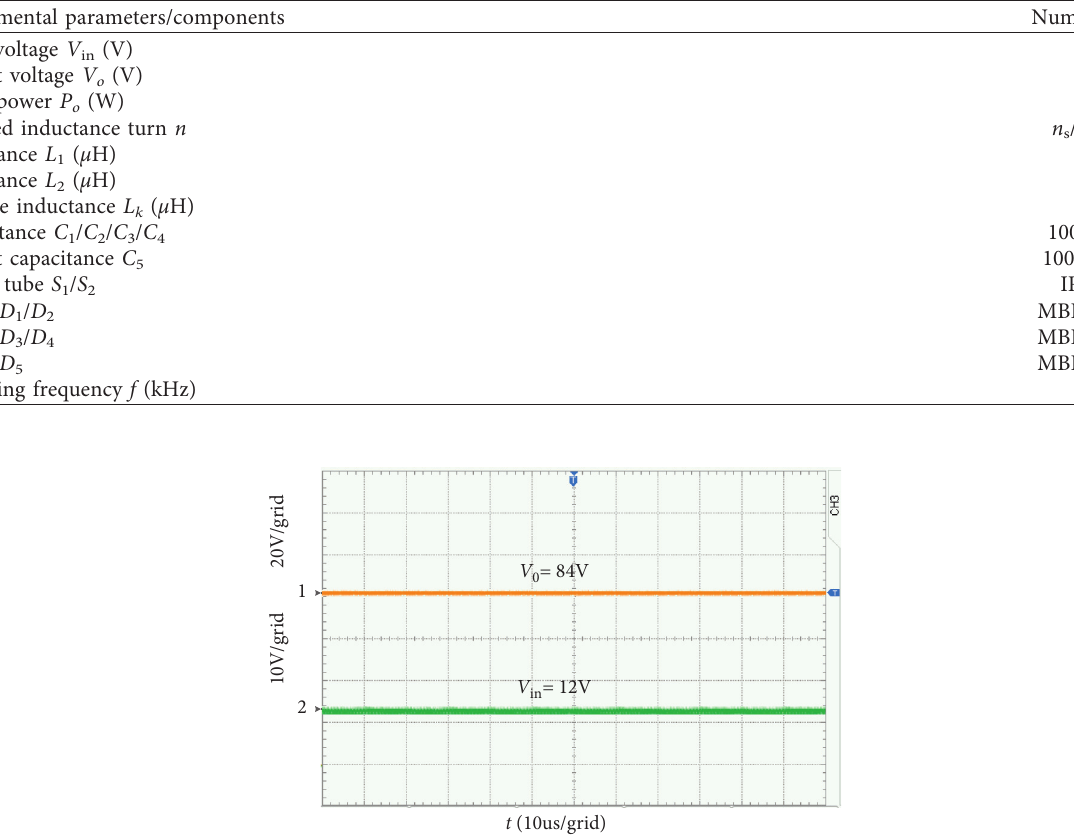
Figure 15: Output/input waveform.